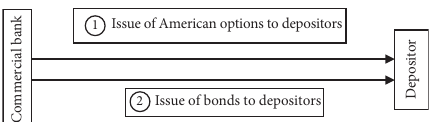
Figure 2: The decomposition of bank deposits with embedded